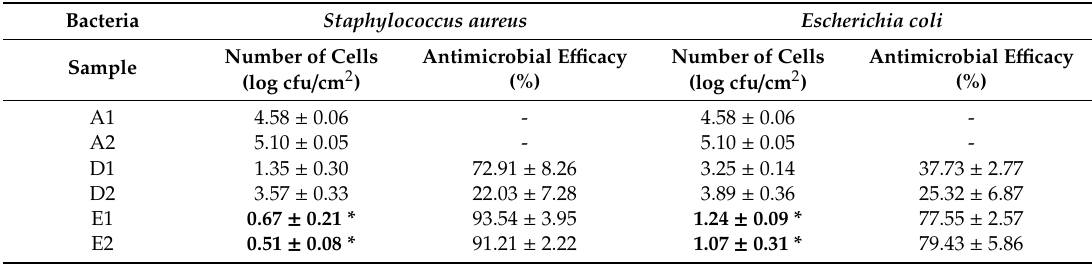
Table 10. Antimicrobial efficacy of gram-positive ( Staphylococcus aureus ) and gram-negative bacteria ( Escherichia coli ). Statistical significance is defined as * p < 0.05 compared to control sample (ANOVA test).